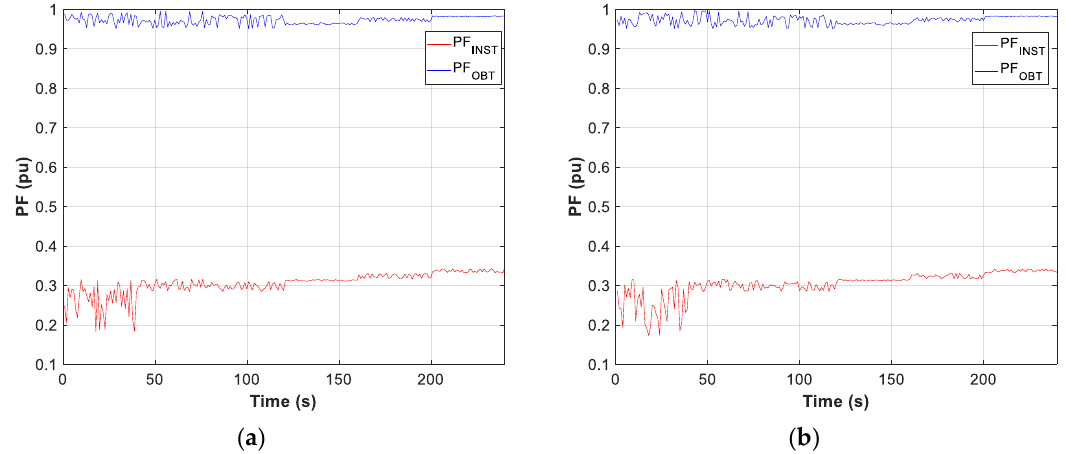
Figure 14. Comparison PF INST vs PF OBT : ( a ) Metal halide; ( b ) Sodium vapour.